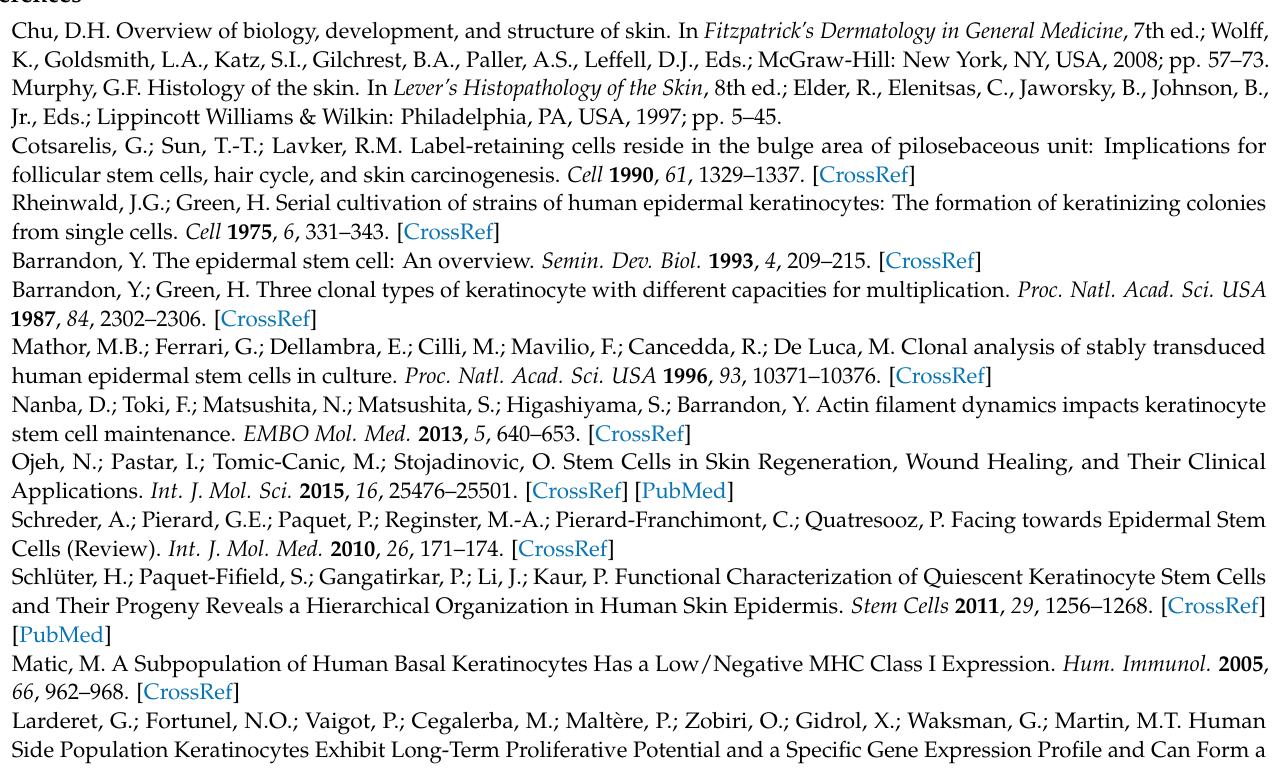
cytometry; Table S1: List of DEGs; Table S2: Signature genes up- and downregulated uniquely in each clonal type; Table S3: Gene ontology (GO) for signature up- and downregulated genes; Table